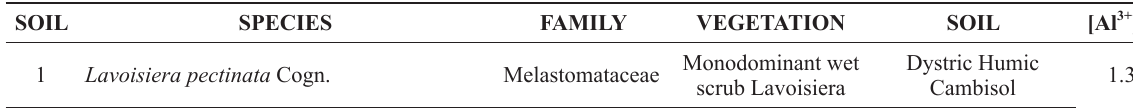
Soils and vegetation types studied at the Serra do Brigadeiro State